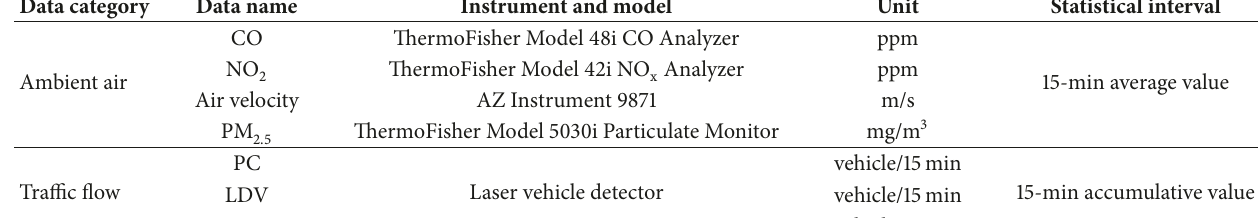
Table 1: Monitoring instruments and data.